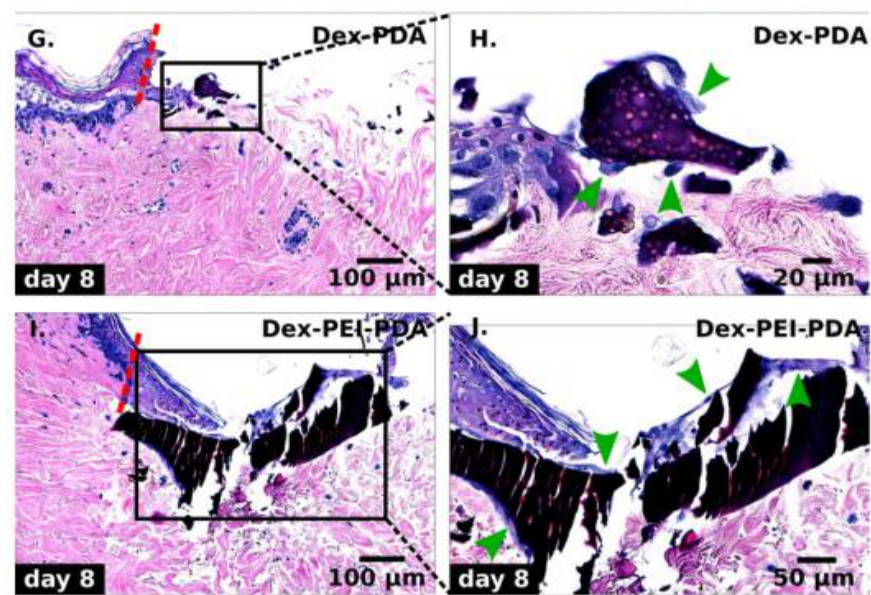
Figure 6. Hematoxylin & Eosin (H&E) stain of transverse section of human abdominal skin explants at 63× after 8 days of treatment with hydrogels. ( A ) Wound created on day 0. ( B ) Phosphate buffered saline (PBS) buffer. ( C and D ) Dextran hydrogel and magnified area. ( E and F ) 2:1 dex-PEI hydrogel and magnified area. ( G and H ) 2:1 dex-PDA hydrogel and magnified area. ( I and J ) 2:1:1 dex-PEI-PDA hydrogel and magnified area. Green arrows indicate epithelial cells interacting with the hydrogels.